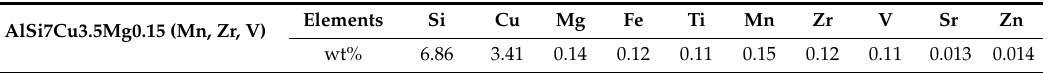
Table 1. General chemical composition of cast alloy from cast